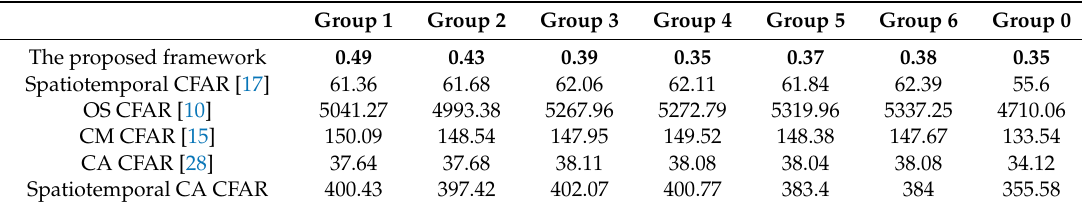
Table 6. Elapsed time of the